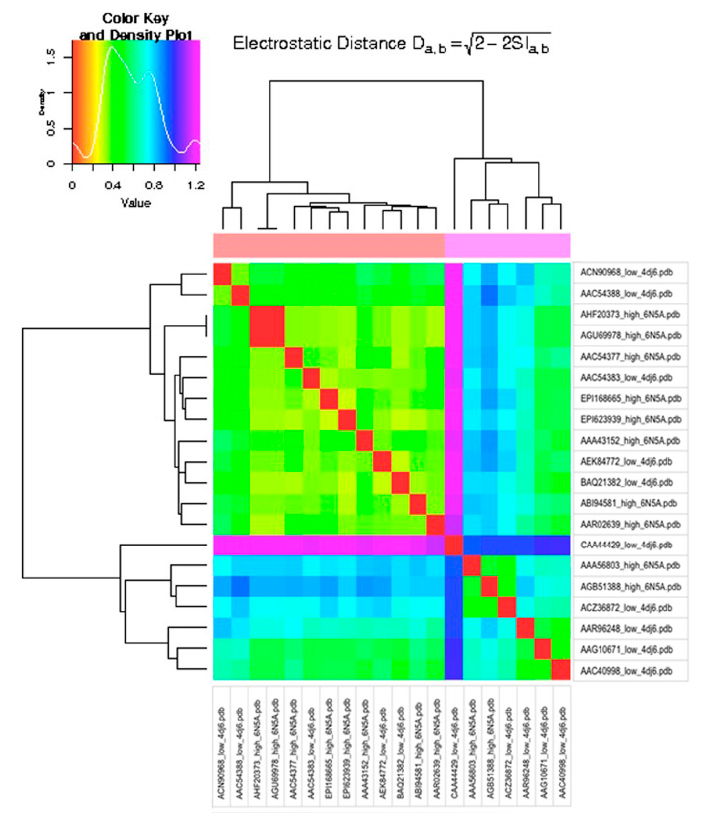
Figure 1. Electrostatic distance heatmap for single template (PDB 4DJ6) models.